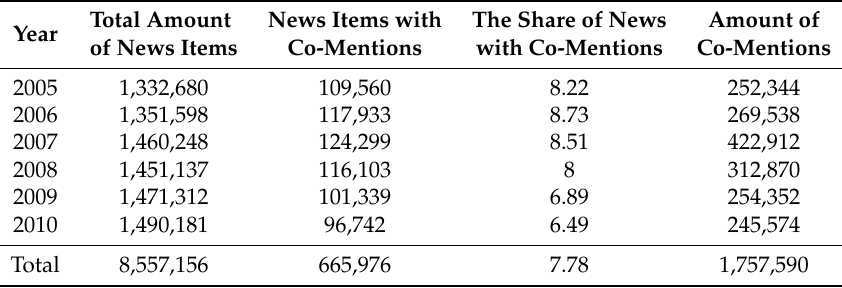
Table 3. The amount of news items in each year from 2005 to 2010.